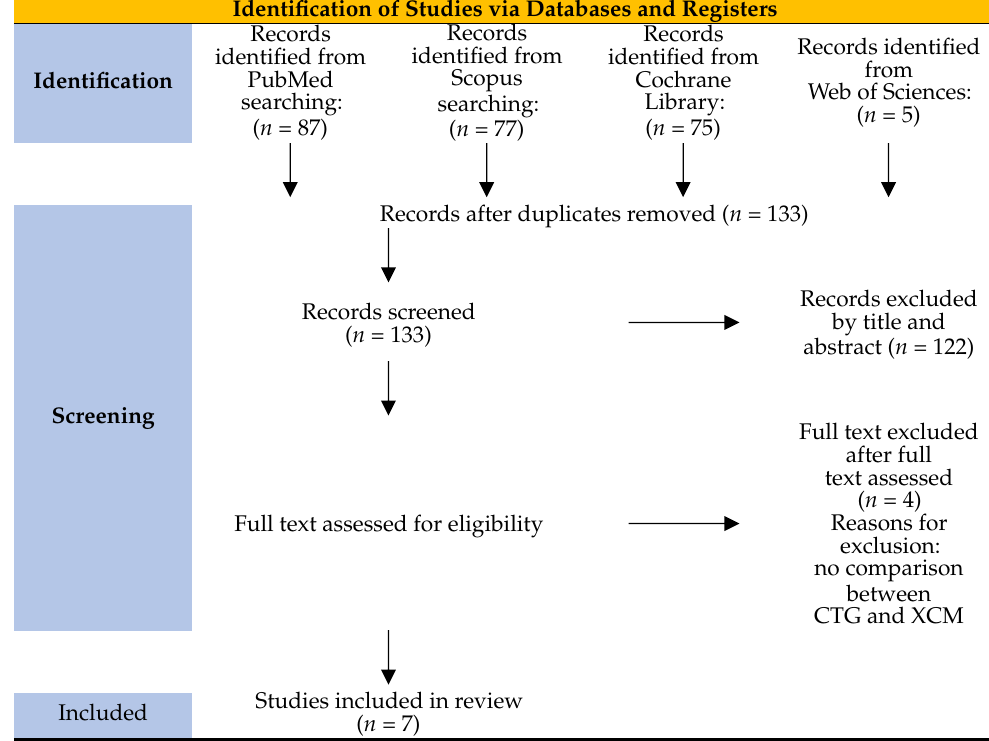
Table 1. PRISMA flow chart.